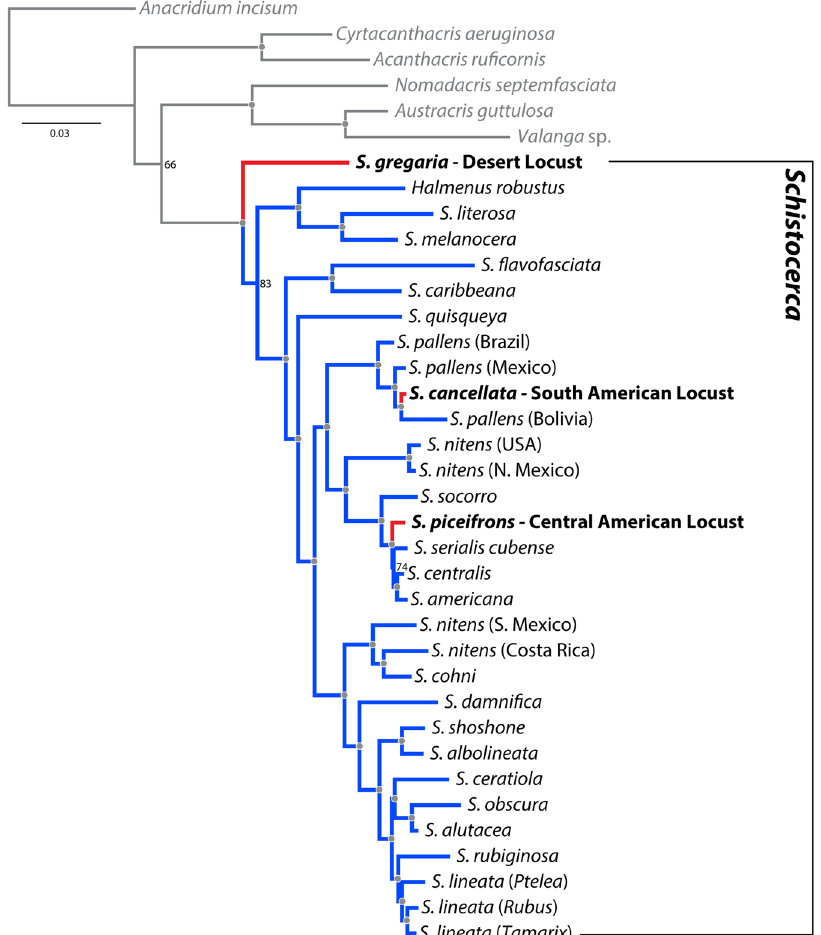
Figure 2. Bayesian tree of Schistocerca based on molecular data. Gray dots on the nodes denote posterior probability of 100. Nodal support values lower than 100 are specified. Red branches indicate swarming locusts and blue branches indicate sedentary